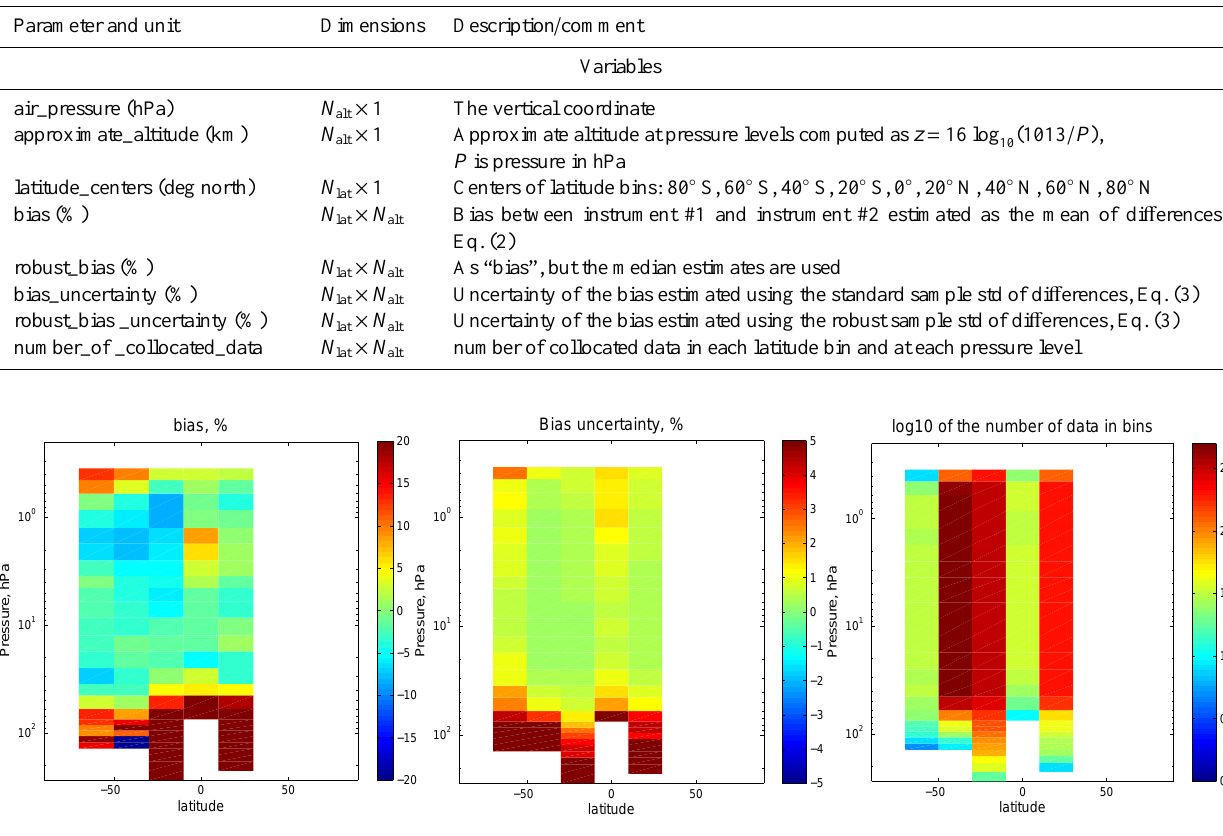
Table 5. A sample visual representation of the main bias parameters is shown in Fig.